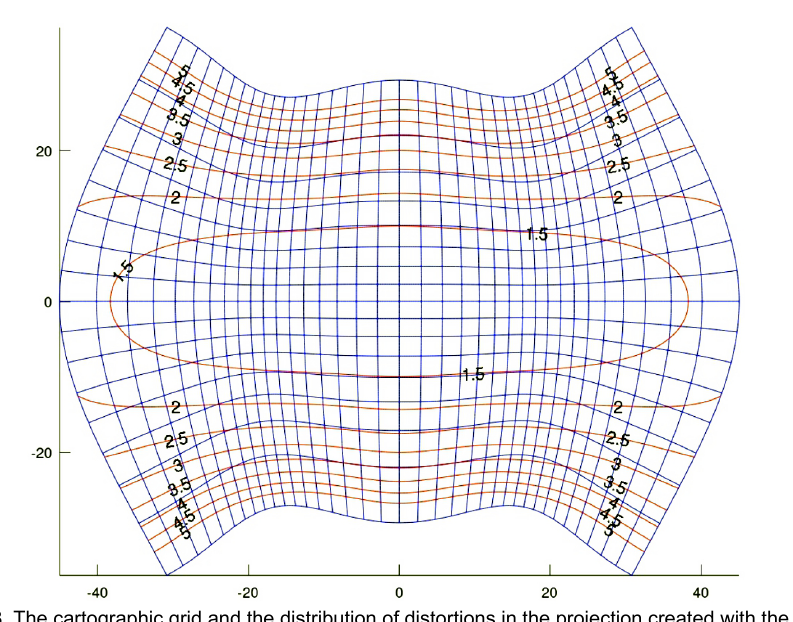
Fig. 18. The cartographic grid and the distribution of distortions in the projection created with the use